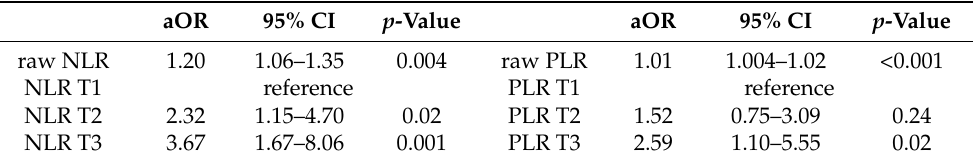
Table 4. Logistic regression analysis showing effect of NLR and PLR on poor functional outcome (mRS 3–6). aOR 95% CI p -Value